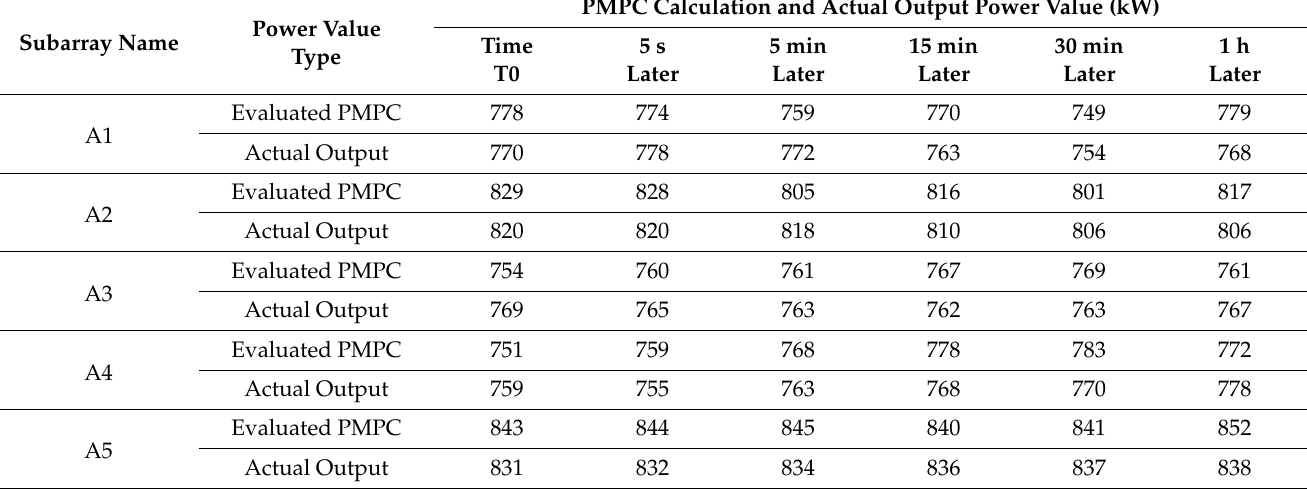
Table 1. Comparison of calculated potential power with real output power.